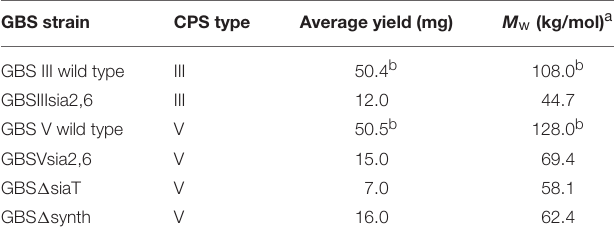
TABLE 2 | Group B Streptococcus (GBS) capsular polysaccharide (CPS) yields and weight-average molecular mass.